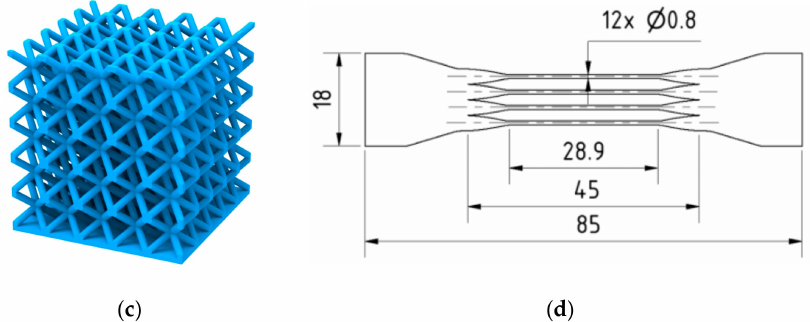
Figure 3. Specimens for ( a ) quasi-static compressive (C-series) and low-velocity impact testing (IT-series); ( b ) quasi-static tensile testing of bulk material (TB-series); ( c ) optical analysis (O-series); and ( d ) quasi-static tensile testing of multi-strut specimens (TS-series).